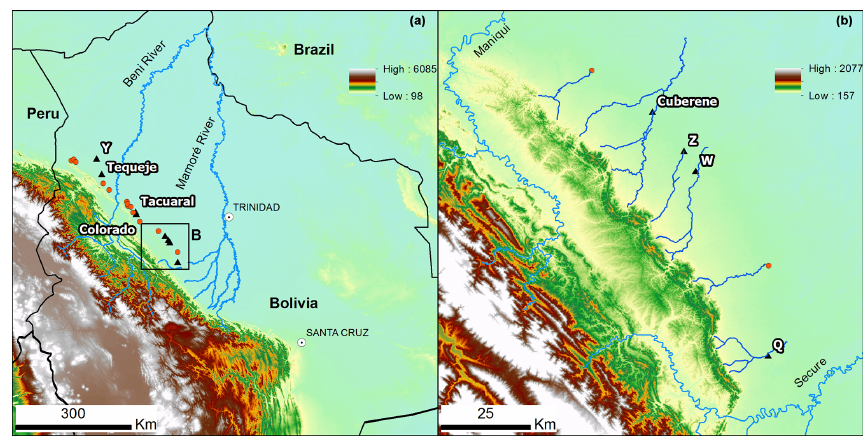
Figure 1. Study area and location of the rivers studied. The study area covers a strip of lowland forest that runs parallel to the Bolivian Andes (approximately 60km wide × 400km long). The black triangles identify the eight rivers analyzed here; the orange dots show the location of other rivers that experience logjam-induced floods but that have not been included in the